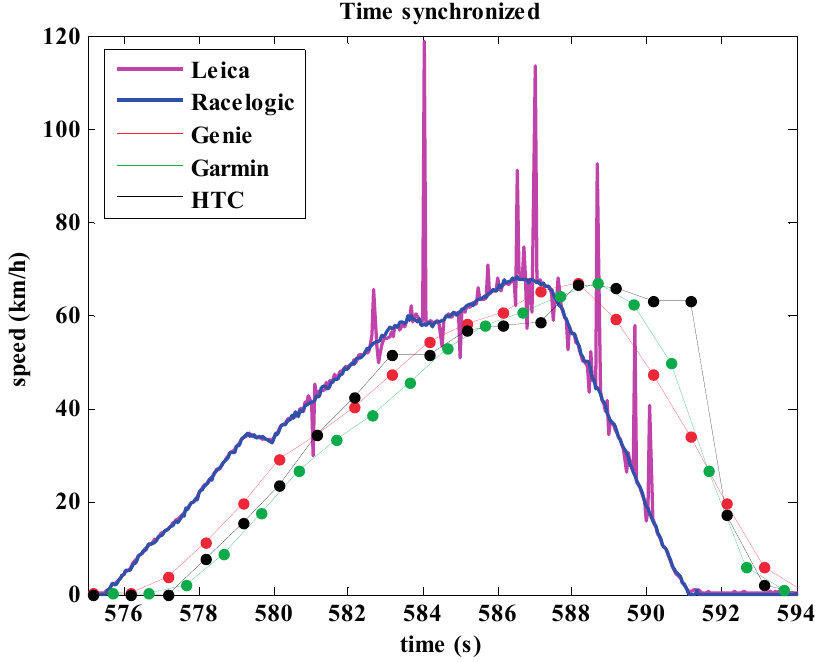
Figure 4. An example of time synchronized speed for all five GNSS devices with an obvious interference in the signal on the Leica system. Note: Leica and Racelogic had 20 Hz sampling rate (bold line) and other systems had 1 Hz sampling rate (full circles, thin line is drawn to help the